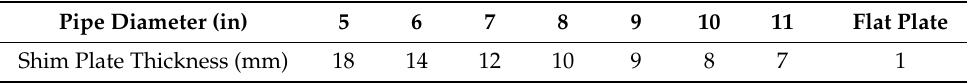
Table 1. The suitable thickness of the shim plate for various pipe sizes. Pipe Diameter (in)